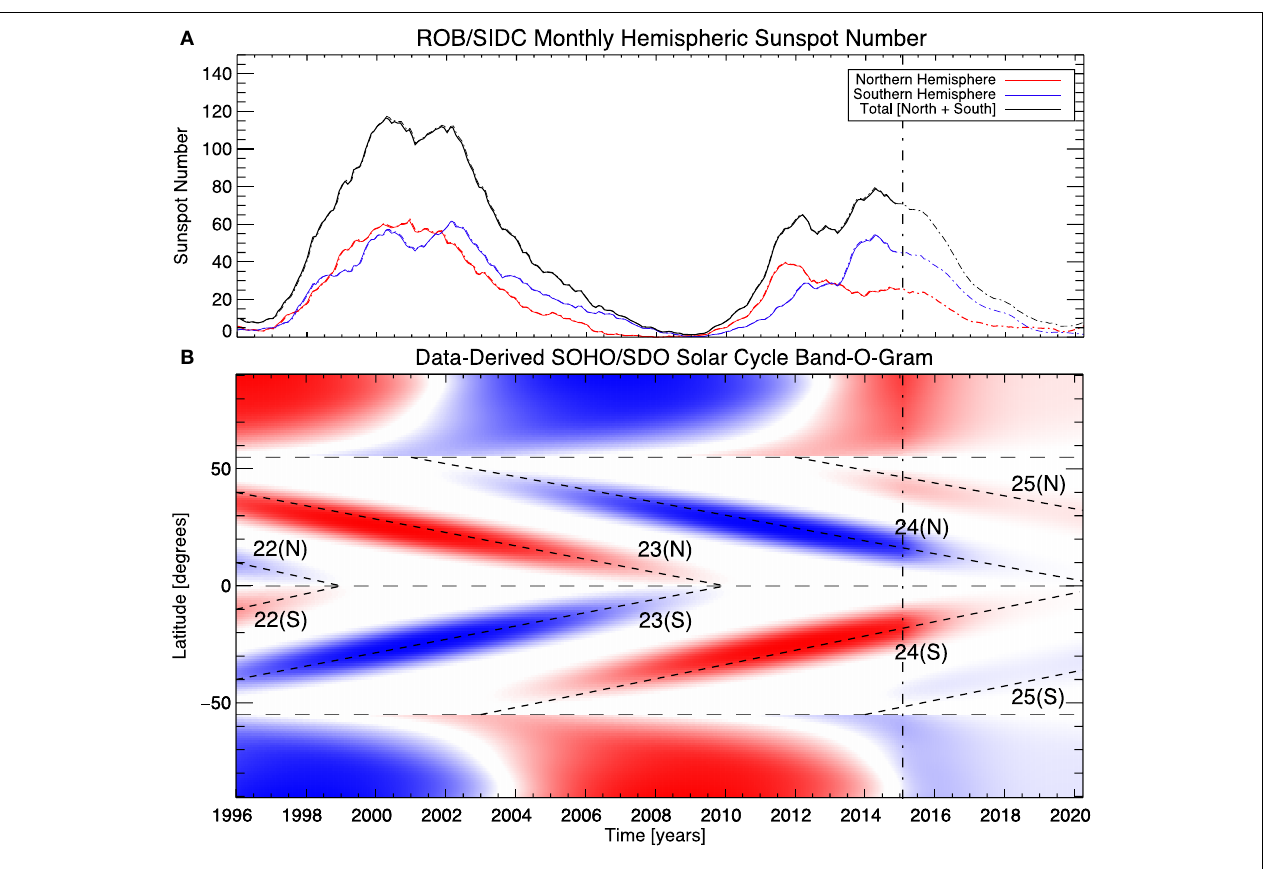
2014, we have attempted to indicate possible future behavior of the system as outlined in McIntosh et al. (2014a) and is shown with an opacity mask. In each case the color of the band reflects its polarity (red–positive; blue–negative). The dashed horizontal lines drawn indicate the equator and lines of the 55th parallel in each hemisphere while the vertical dot-dashed lines indicate the current time. Source: WDC-SILSO, Royal Observatory of Belgium,